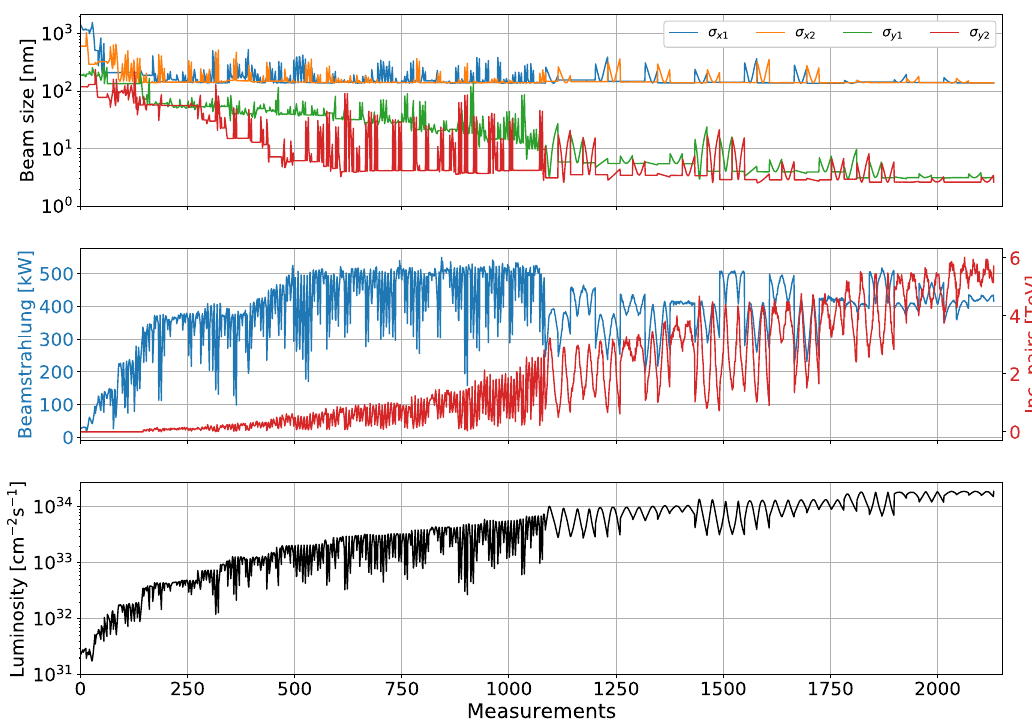
FIG. 9. The luminosity tuning evolution of the median machine after beam-based alignment has been performed. The horizontal axis display the number of measurements. Top: The horizontal and vertical beam sizes of the two beams. Middle: The two tuning signals. Bottom: The luminosity — this signal is only for reference and was not used in the tuning